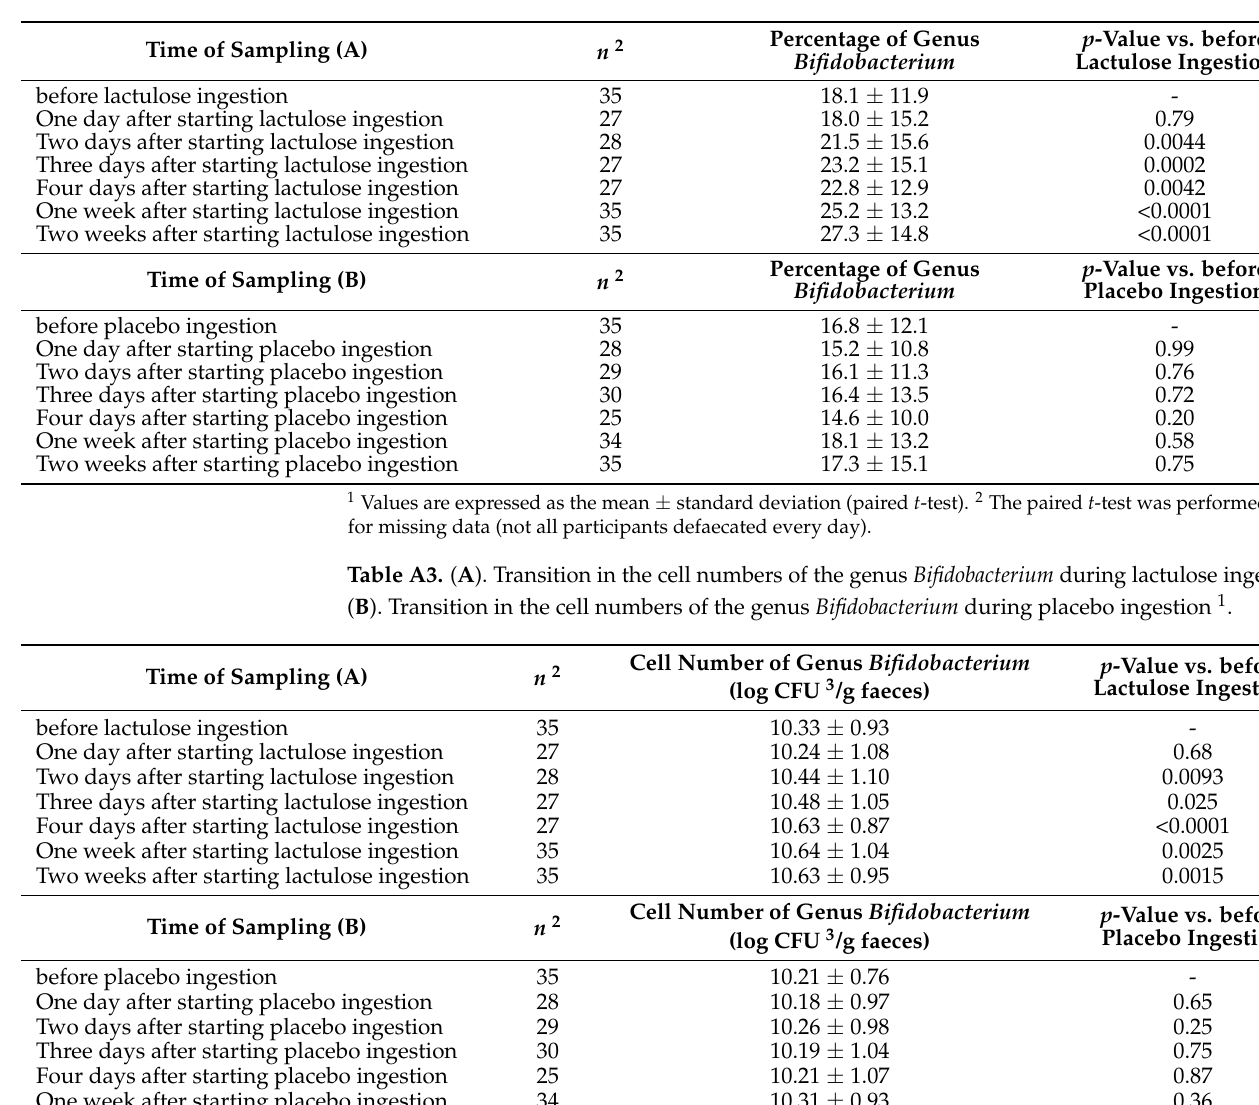
Table A2. ( A ). Transition in the percentages of the genus Bifidobacterium during lactulose ingestion 1 . ( B ). Transition in the percentages of the genus Bifidobacterium during placebo ingestion 1 .